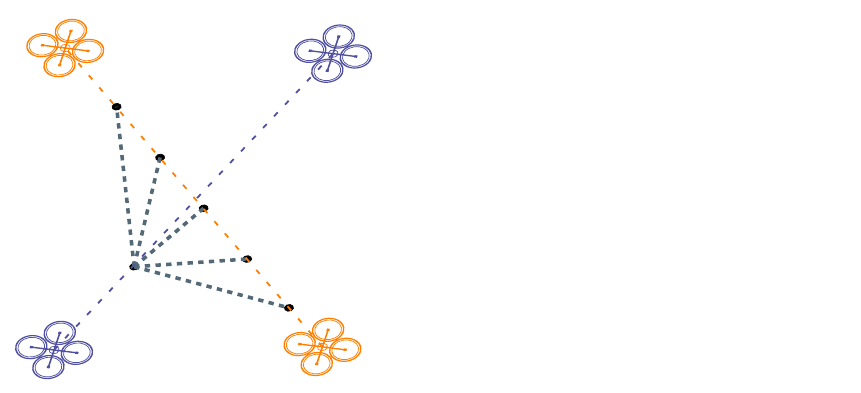
Figure 4. Comparison between intermediate positions in the flight trajectories of two drones.